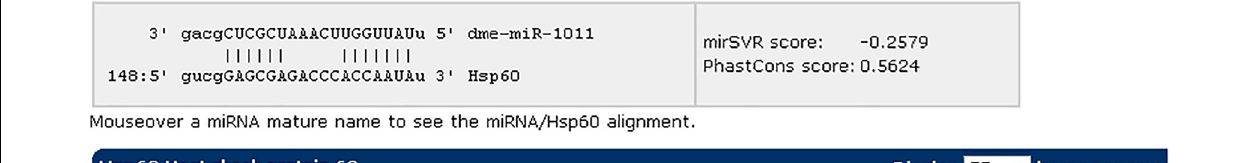
Frontiers in Physiology |